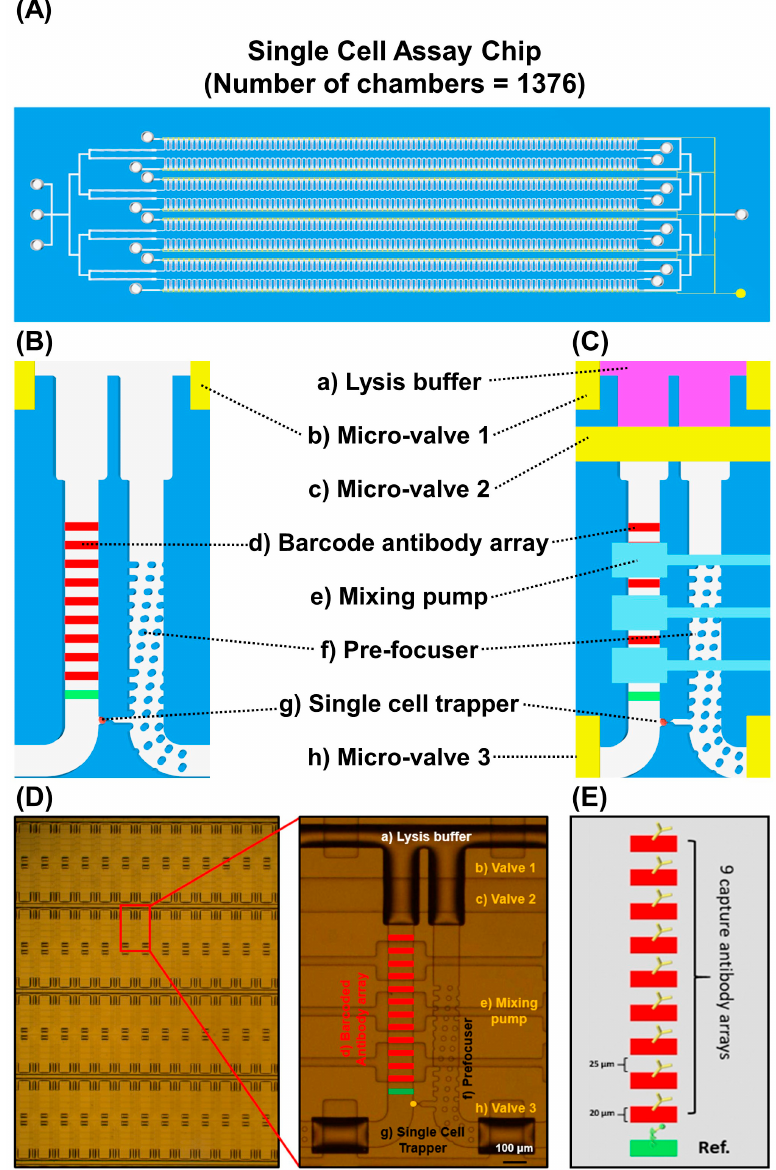
Figure 1. Design of single-cell proteomics assay chip. ( A ) Schematic drawing of the single-cell assay chip. ( B , C ) A schematic view of a single chamber. ( D ) Real image of single-cell proteomics assay chip. ( E ) Schematic view of multiplexed capture antibody arrays comprising a reference probe (green) and captured antibody arrays (red).